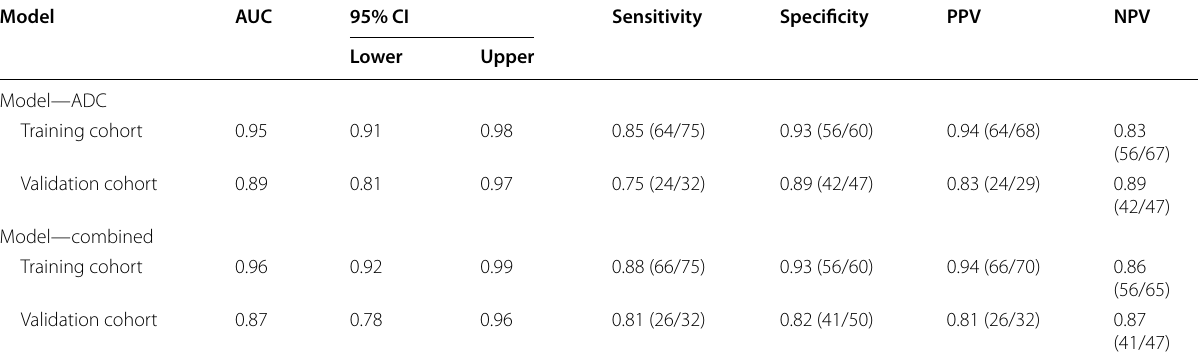
Table 4 Predictive performances of two models in predicting the radiation-induced temporal lobe injury in the training and validation